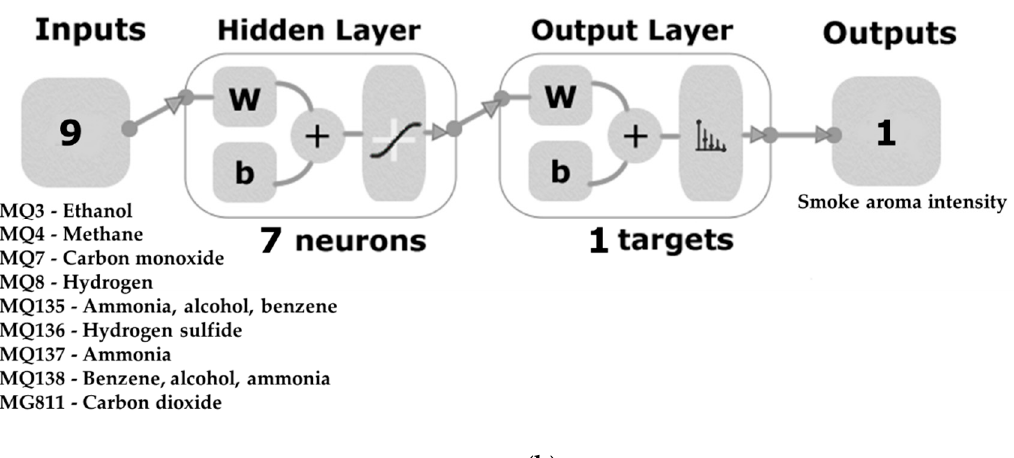
Figure 6. Two-layer feedforward network for the artificial neural network models developed to predict: ( a ) the levels of volatile aromatic compounds present in wine (Model 1) and ( b ) smoke aroma intensity (Model 2). Abbreviations: W = weights, b = biases.